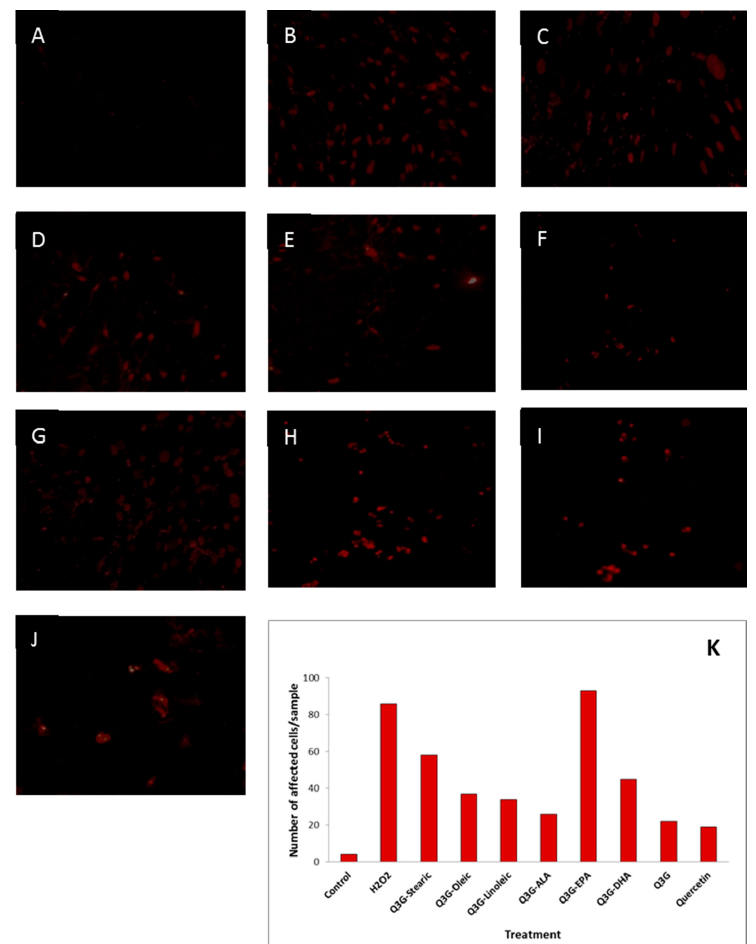
Figure 10. Effect of test compounds on H 2 O 2 -induced late apoptotic/necrotic cell death of WI-38